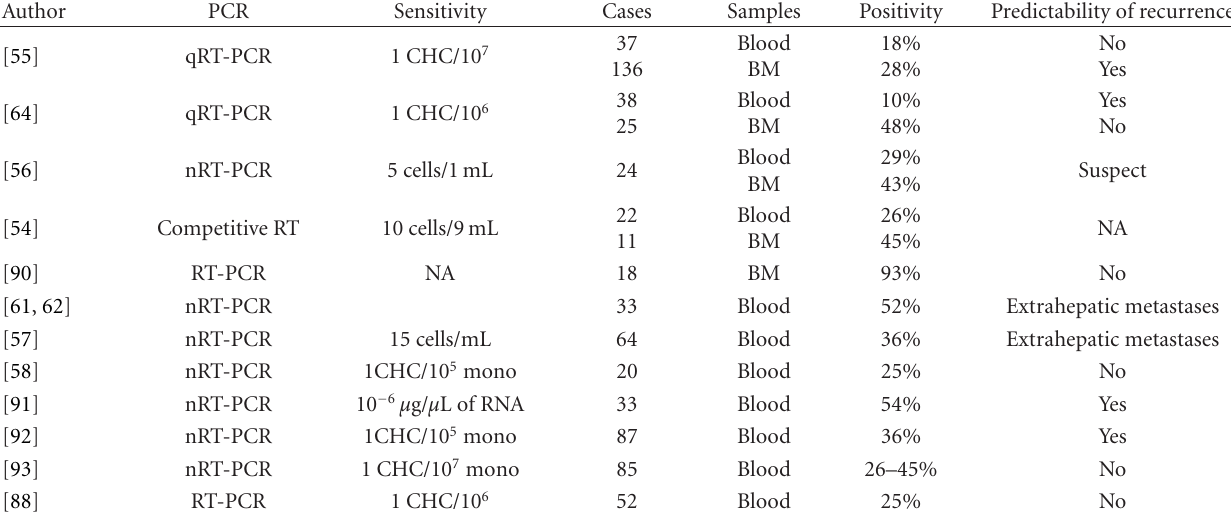
Table 1: Evaluation of serum alpha fetoprotein as a marker of circulation tumor cell in di ff erent hepatocellular carcinoma studies. nRT-PCR, nested RT-PCR; qRT-PCR, quantitative